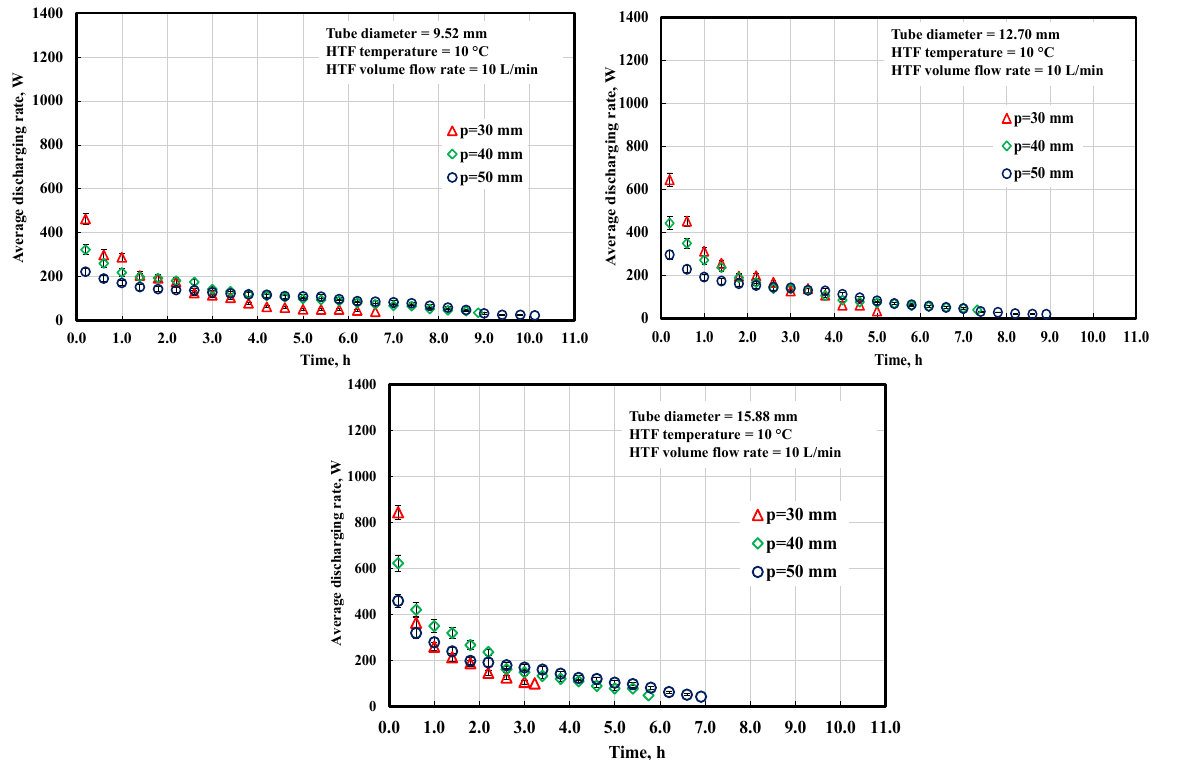
Figure 5. Average charging rate with time for different coil pitches with coil tube diameters during the charging process.